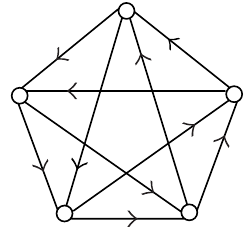
Figure 1.2 . An oriented graph in which every pair of vertices is a hull